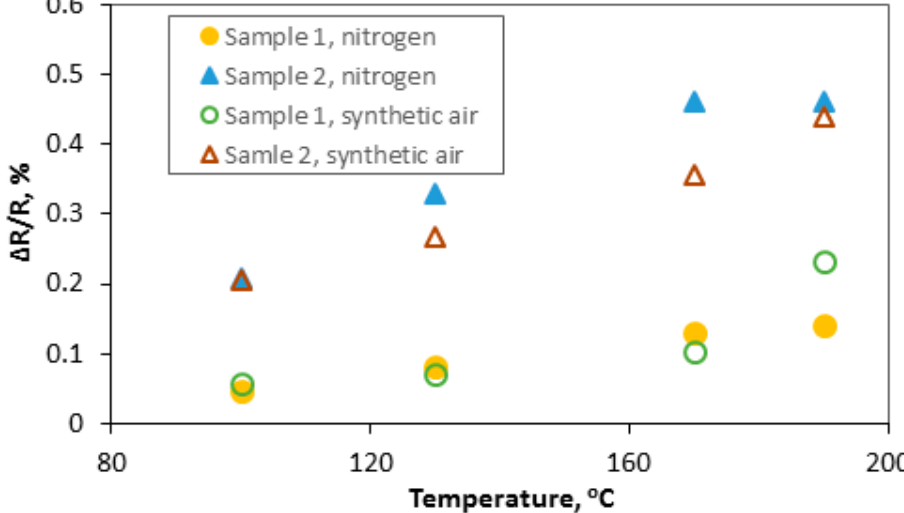
Figure A5. Diffractograms of graphite oxide and thermally reduced graphene oxide.